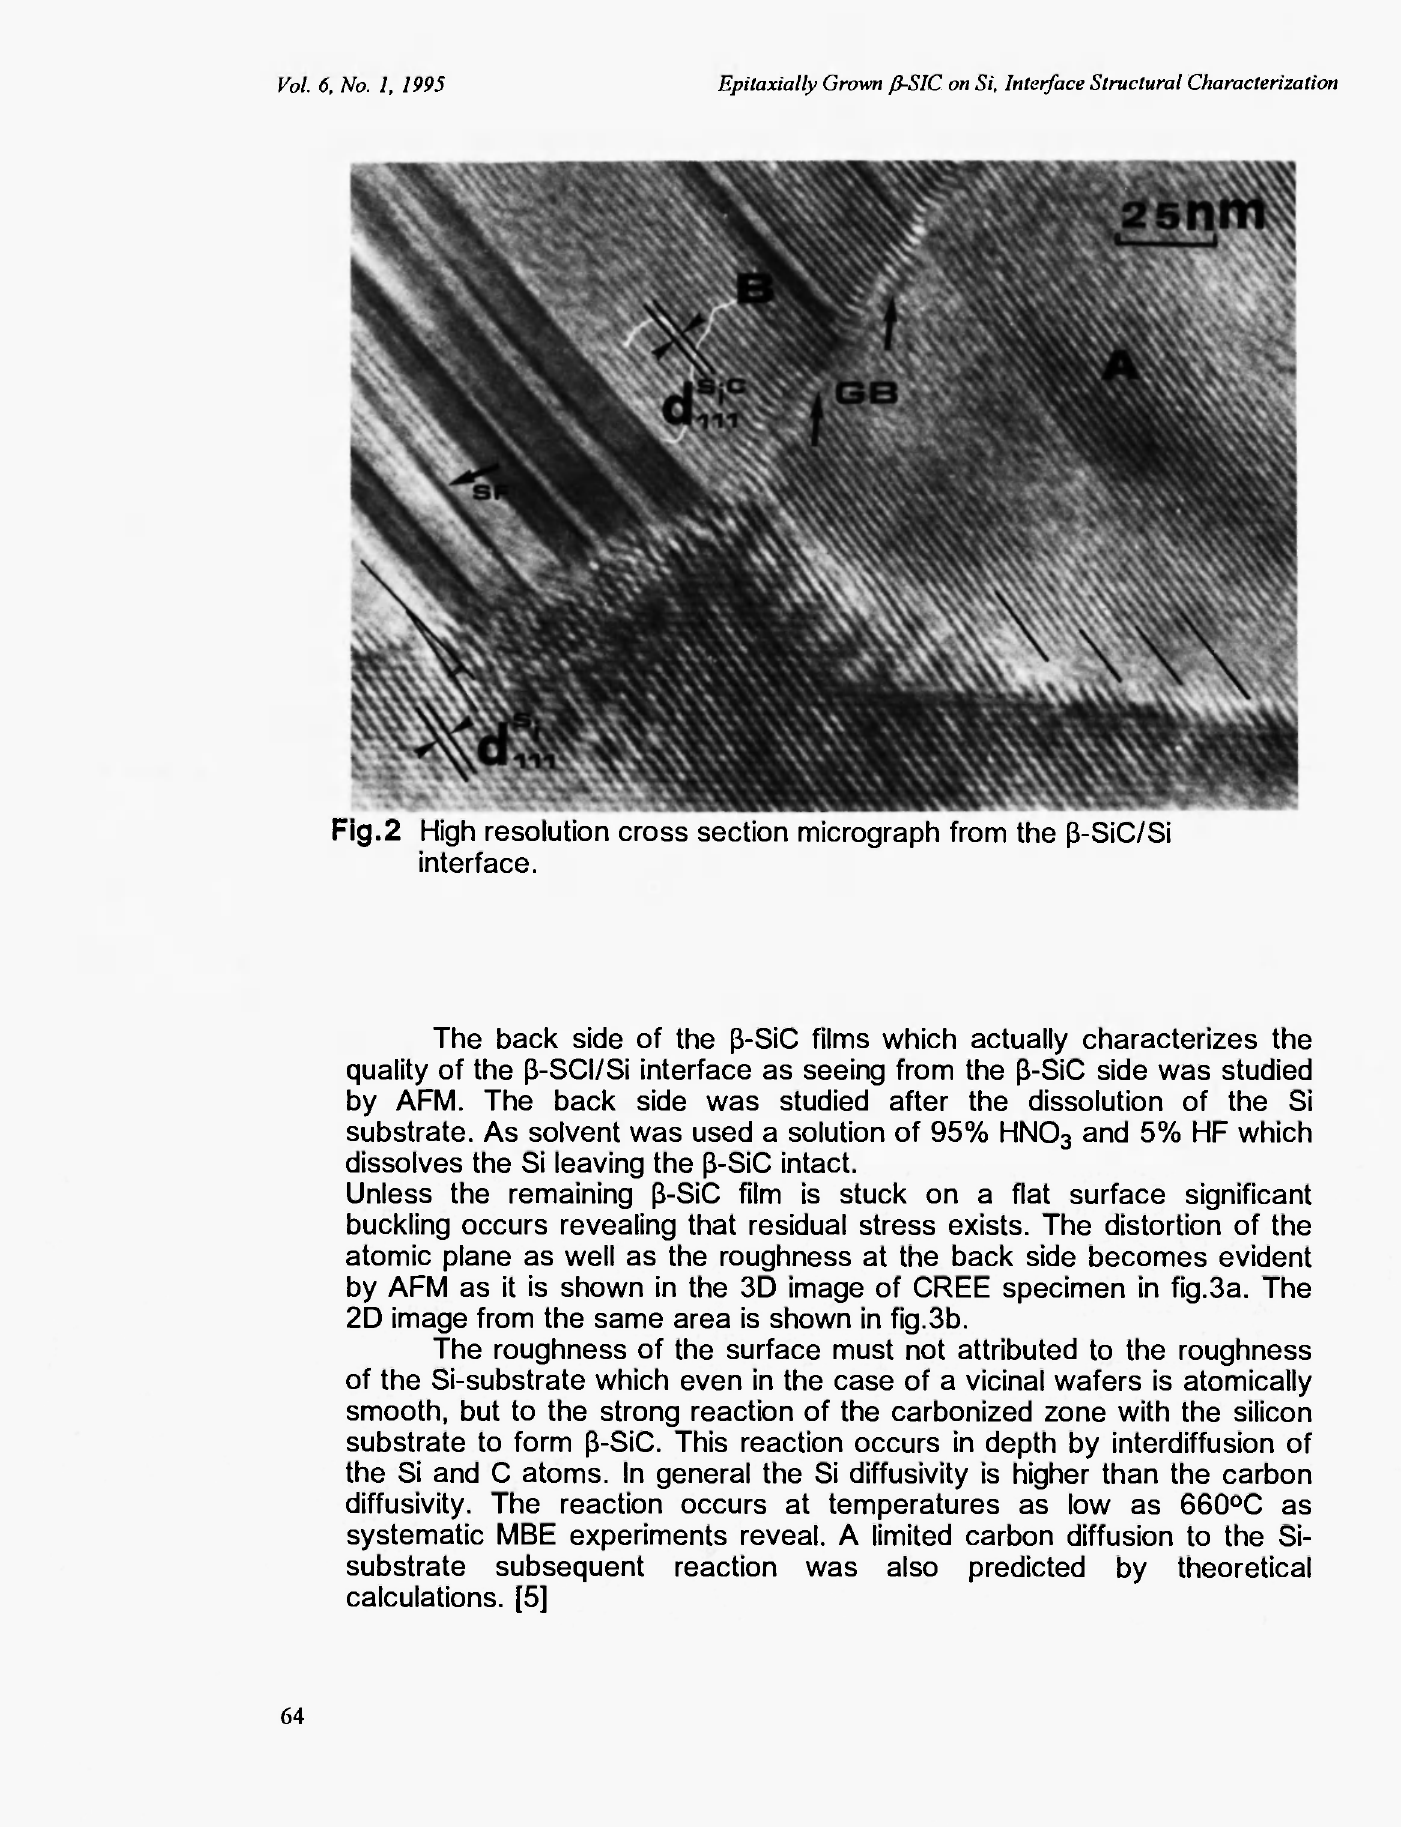
Fig.2 High resolution cross section micrograph from the ß-SiC/Si